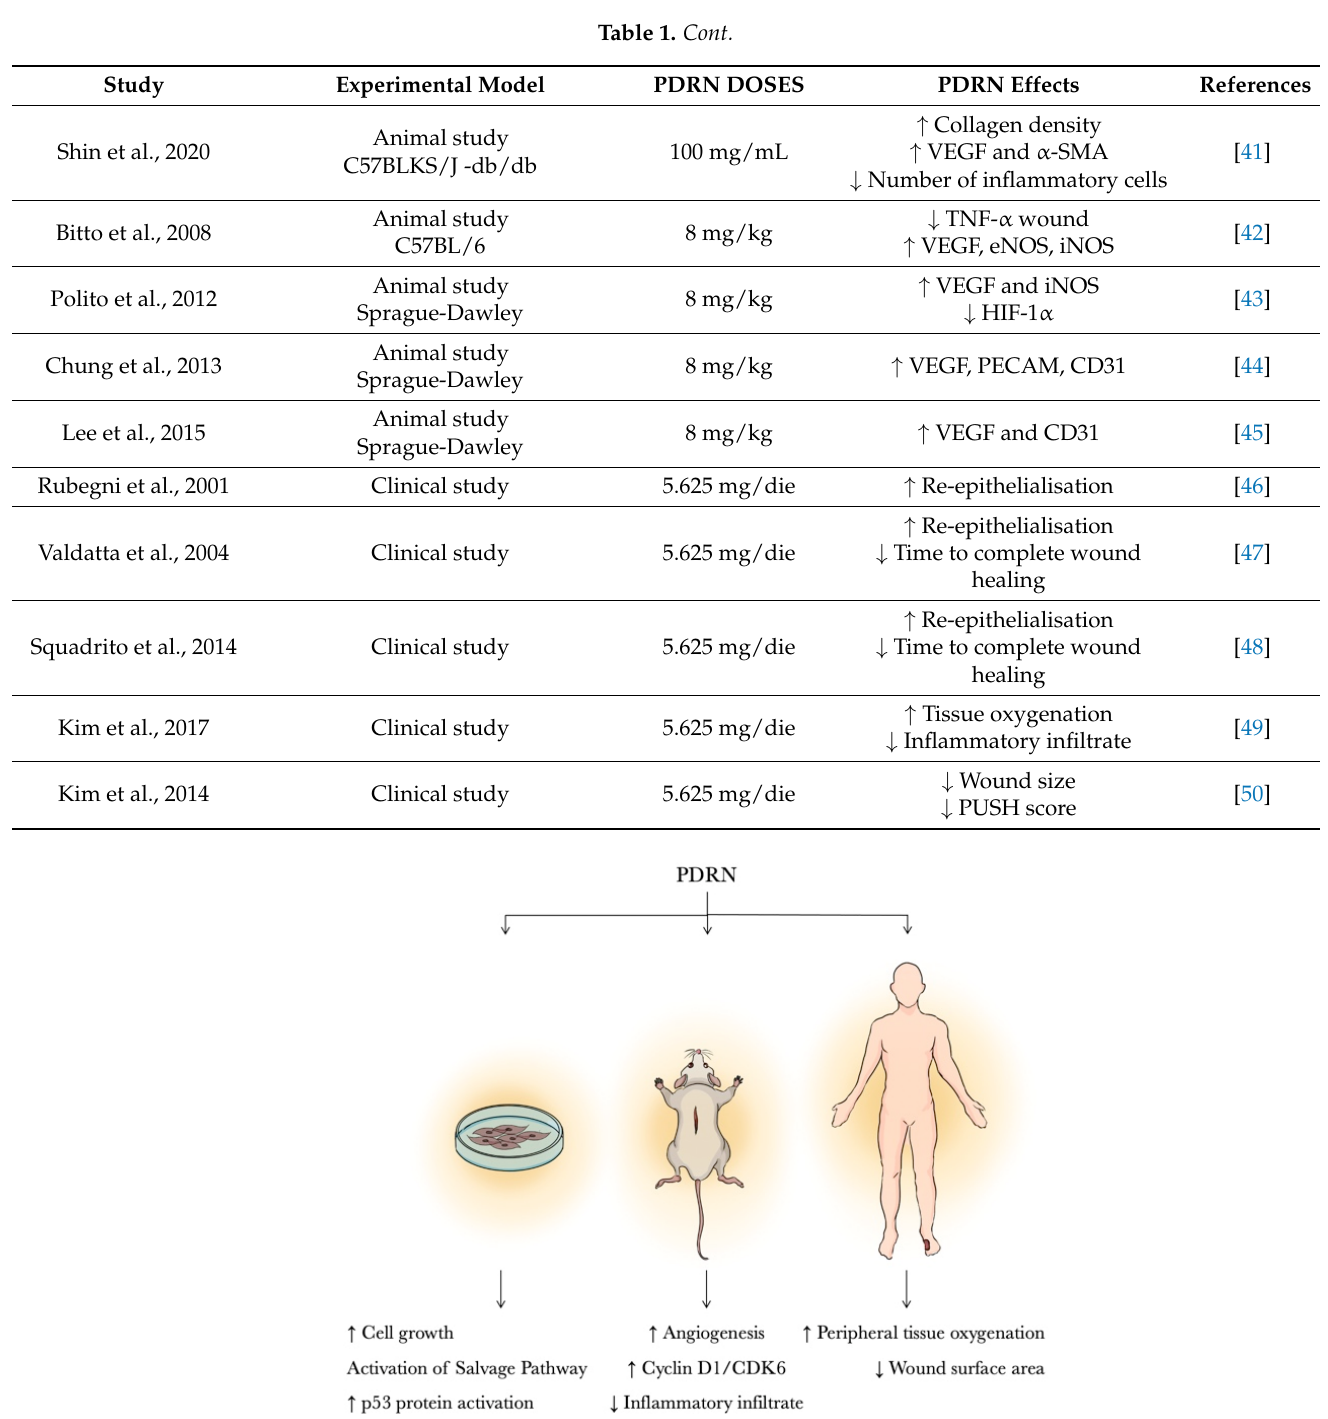
Figure 2. PDRN effects in: in vitro, animal and clinical studies.